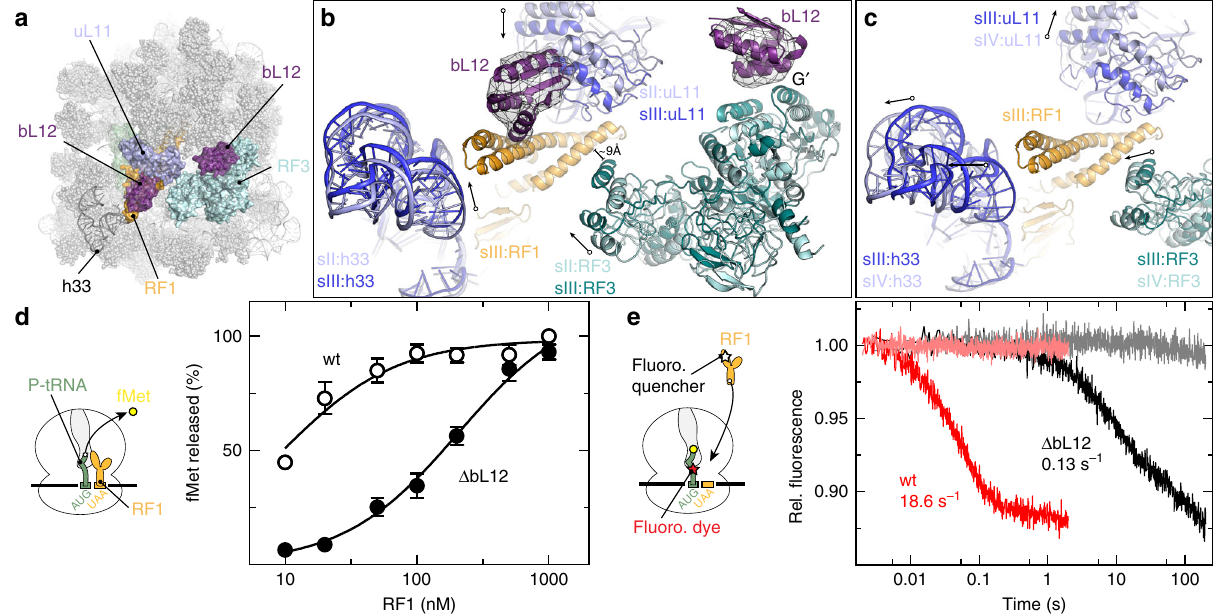
Fig. 5 Interaction of bL12 with RF1 and RF3 in state III. a Overview showing the relative position of RF1 (orange), RF3 (pale cyan), uL11 (light blue), 23S rRNA helix h33 (dark grey) and two copies of the bL12 CTD (purple) on the ribosome (light grey). b Comparison of state II position for RF3 (pale cyan), uL11 and h33 (light blue) with state III positions for RF3 (teal), uL11 and helix h33 (dark blue). In state III, RF1 domain I (orange) becomes ordered and density (grey mesh, fi ltered to 7 Å) for two copies of bL12 CTD (purple) are observed. c Comparison of state III positions from ( b ) with state IV positions for RF3 (pale cyan), uL11 and h33 (light blue). d Peptide hydrolysis by RF1 in the presence of wild type (wt, open circles) or bL12-depleted ( Δ bL12, closed circles) ribosomes. Pre-hydrolysis (PreHC) complexes (0.01 µ M) were incubated with increasing concentrations of RF1 for 10 s at 37 °C. Solid lines represent the hyperbolic fi t of the experimental points. Error bars represent the standard deviation of the mean for four technical replicates from two independent biological experiments. The apparent af fi nities of RF1 for wt and Δ bL12 PreHCs are 9 ± 1 and 210 ± 30 nM, respectively. e Time courses of RF1-GAQ Qsy9 (0.3 µ M) binding to PreHC Flu (0.05 µ M) prepared with wt (red) or Δ bL12 (black) ribosomes. Buffer controls are shown in salmon and grey, respectively. Traces shown are the average of four to fi ve technical